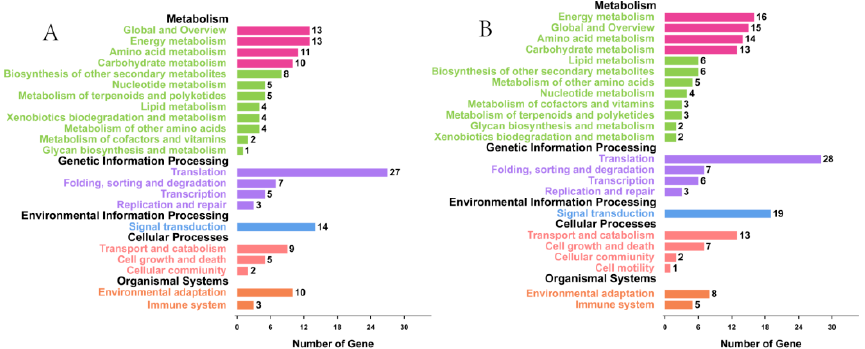
Figure 5. The Kyoto Encyclopedia of Genes and Genomes (KEGG) enrichment analyses of DEGs from the flower bud ( A ) and stem apex ( B ).